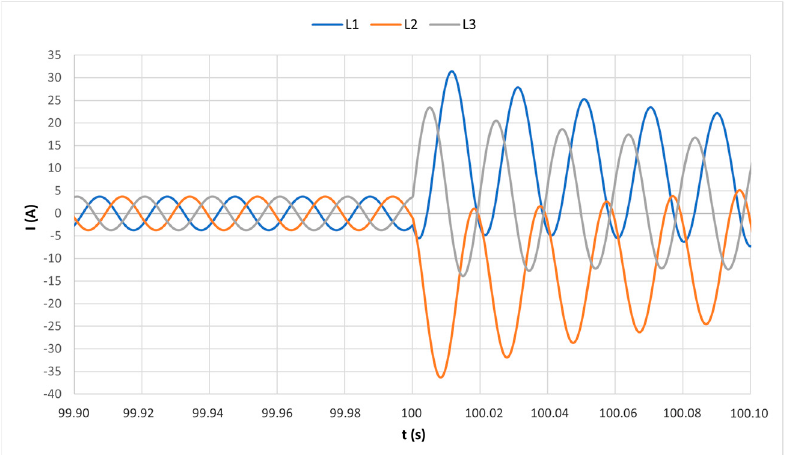
Figure 23. Simulated values of thermal power plant model currents during a 3-Ph ground fault condition at the source.